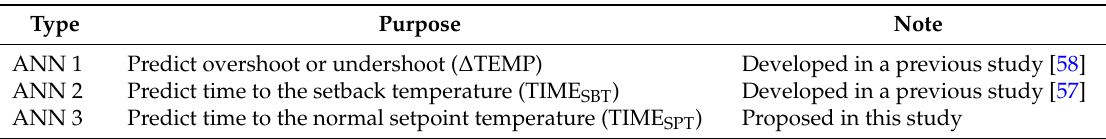
Table 3. ANN models applied in the control